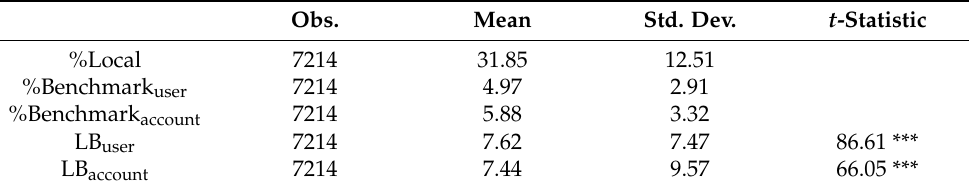
Table 2. Empirical Results of Local Bias.